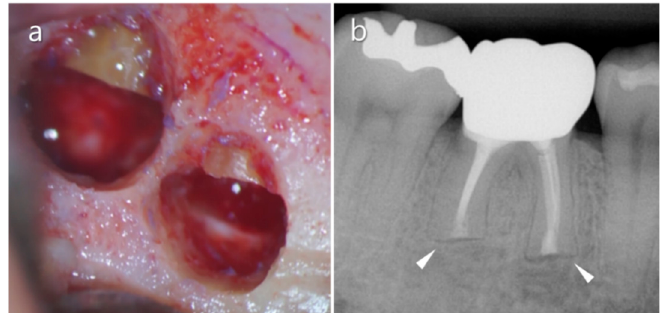
Figure 13. A contemporary technique for root resection. ( a ) Clinical features of mesial and distal roots resected perpendicular to the long axis of each root. ( b ) A periapical X-ray image taken using the parallel technique shows resection with a shallow bevel. Note that complete bony healing occurred with continuous lamina dura.